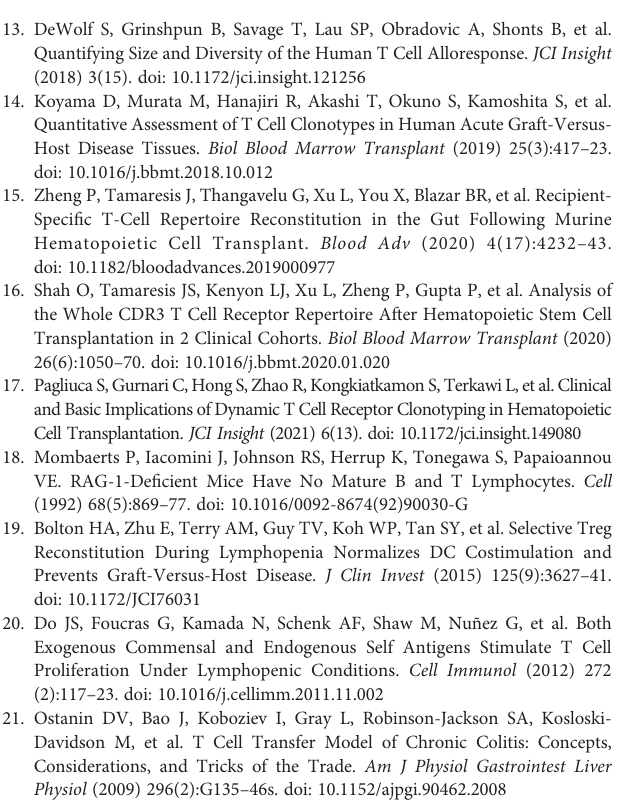
On day 7 (B) and day 14 (D) , recipient splenocytes were subjected for fl ow testing of H2K b expression on gated live cells and TCRv b and CD45.1 expression on gated H2K b+ live cells from 3 replicate recipients. Supplementary Figure 2 | Top 10 clones in all recipients after BMT. Rag1 -/- BALB/c or Rag1 -/- B6 mice were conditioned with total body irradiation (TBI) administered 550cGy (BALB/c) or 750cGy (B6) using an X-RAD 320 X-ray Irradiator.Puri fi edTcells(1×10 6 )fromCD45.1 + B6micetogetherwithbonemarrow cells (5×10 6 ) isolated form Rag1 -/- B6 were i.v. injected into these recipient mice within 24h after TBI. On day 7 and day 14, gDNA were acquired from relevant tissues from individual recipient mice for TCR b sequencing. Unique sequence was de fi ned by CDR3 amino acid + V gene + J gene. The structure of the top 10 clones, sum of template and number of samples containing the top 10 clones are shown across all the samples tested. Supplementary Figure 3 | Frequency of top clones in recipients after BMT. Rag1 -/- BALB/c or Rag1 -/- B6 mice were conditioned with total body irradiation (TBI) administered 550cGy (BALB/c) or 750cGy (B6) using an X-RAD 320 X-ray Irradiator. Puri fi ed T cells (1×10 6 ) from B6 mice together with bone marrow cells (5×10 6 ) isolated form Rag1 -/- B6 were i.v. injected into these recipient mice within 24h after TBI. On day 7 and day 14, gDNA were acquired from relevant tissues from individual recipient mice for TCR b sequencing. The frequency of top 5, 10, 20 and 30 clones in total templates were analyzed in each recipient organs after BMT (A, B)